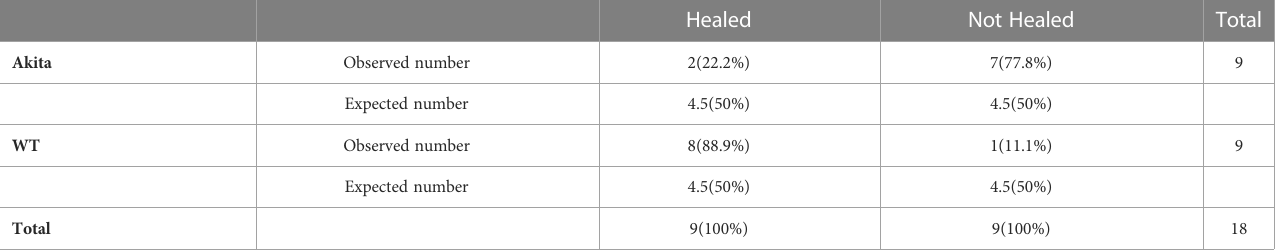
TABLE 1 Contingency table for Pearson chi-square test analysis of number and percentage (in brackets) of WT and Akita mice healed at day 3 after corneal alkaline injury (degrees of freedom = 1, signi fi cance level = 0.05). Healed Not Healed Total Akita Observed